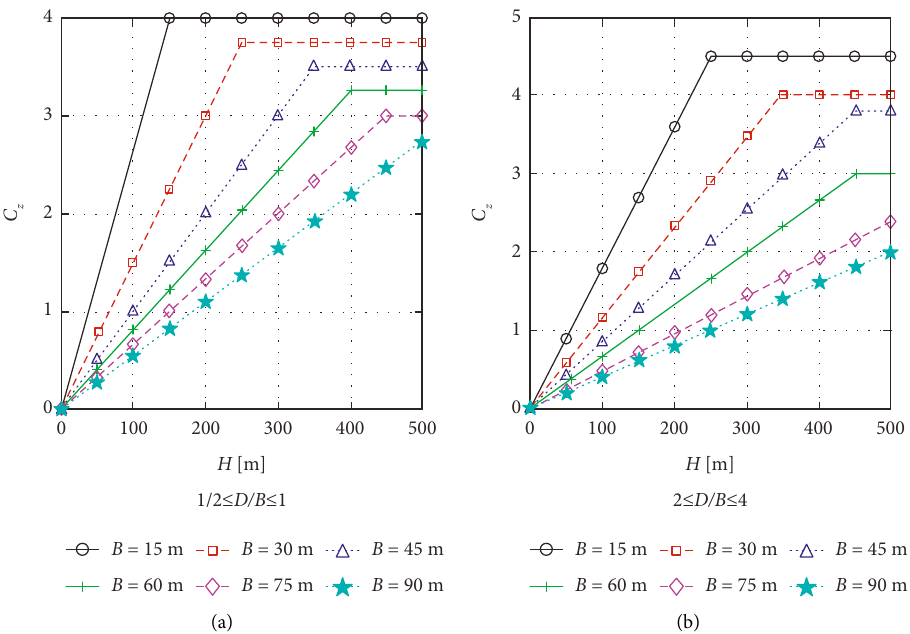
Figure 14: Proposed vertical decay constants for wind-induced torque on rectangular tall buildings 2 ≦ D/B ≦ 4 .